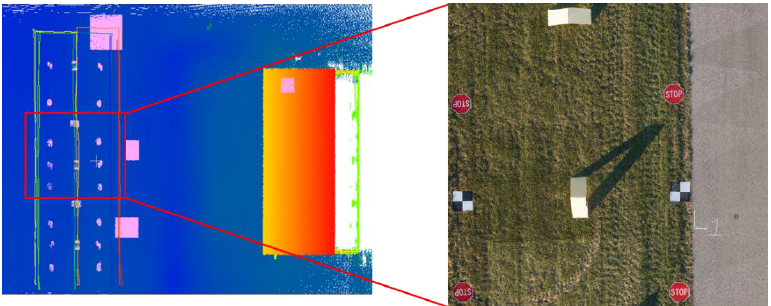
Figure 9. Configuration of flight lines and target primitives used for calibration as visible in 3D point clouds and Red, Green, Blue (RGB) orthophoto.